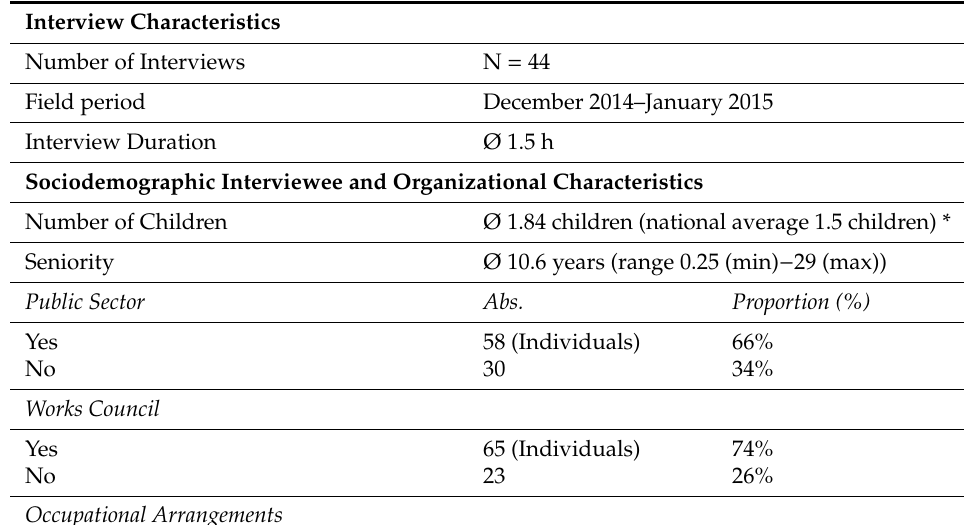
Table A4. Characteristics of the sample of semi-structured